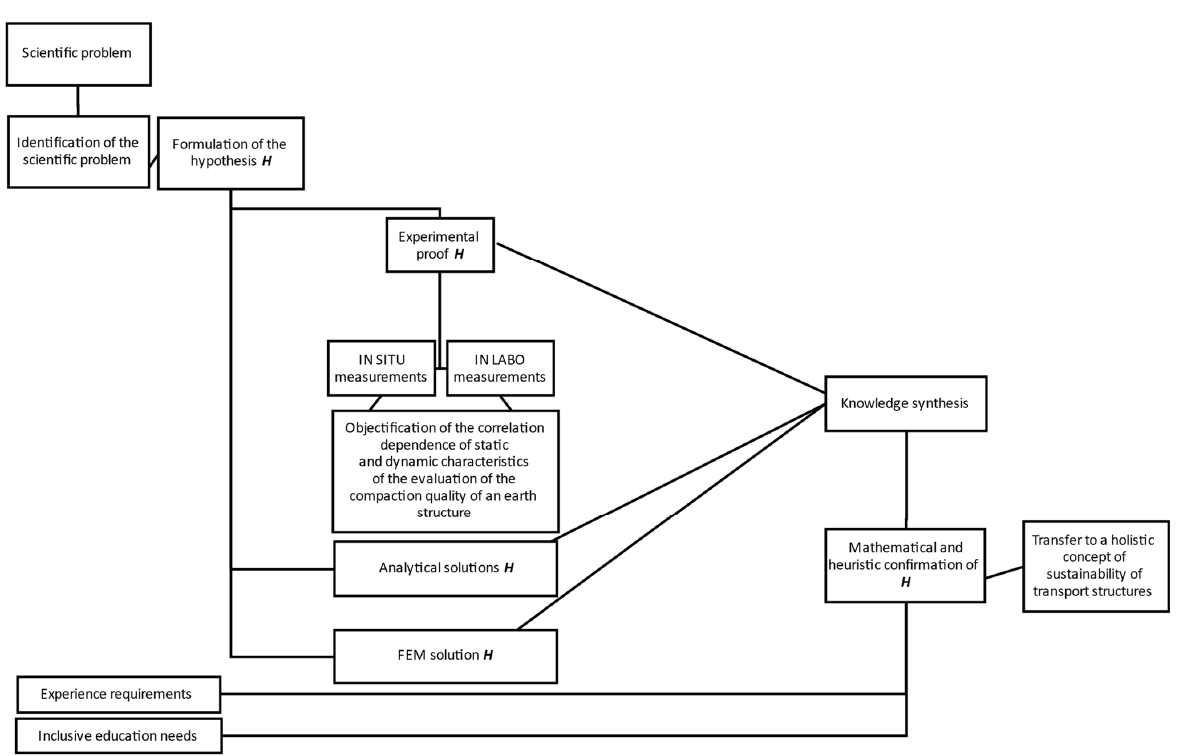
Figure 1. Diagram of investigation related to dynamic vs. static deformation modulus of different materials used for earthworks quality control.